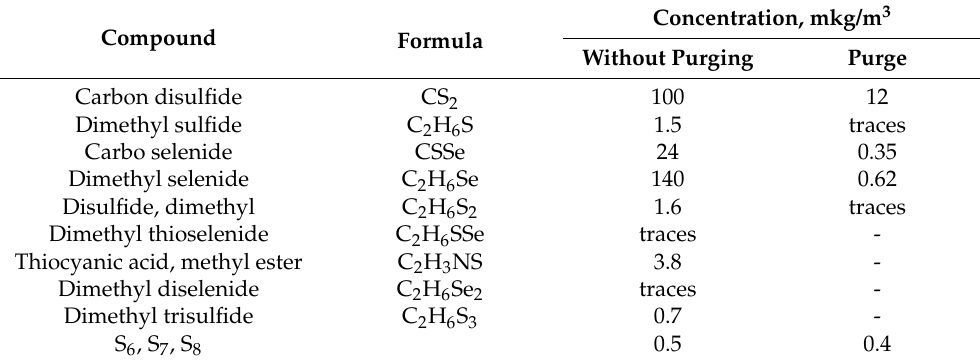
Table 5. Concentrations of the gases over the substance of the test sample under stationary conditions and in the